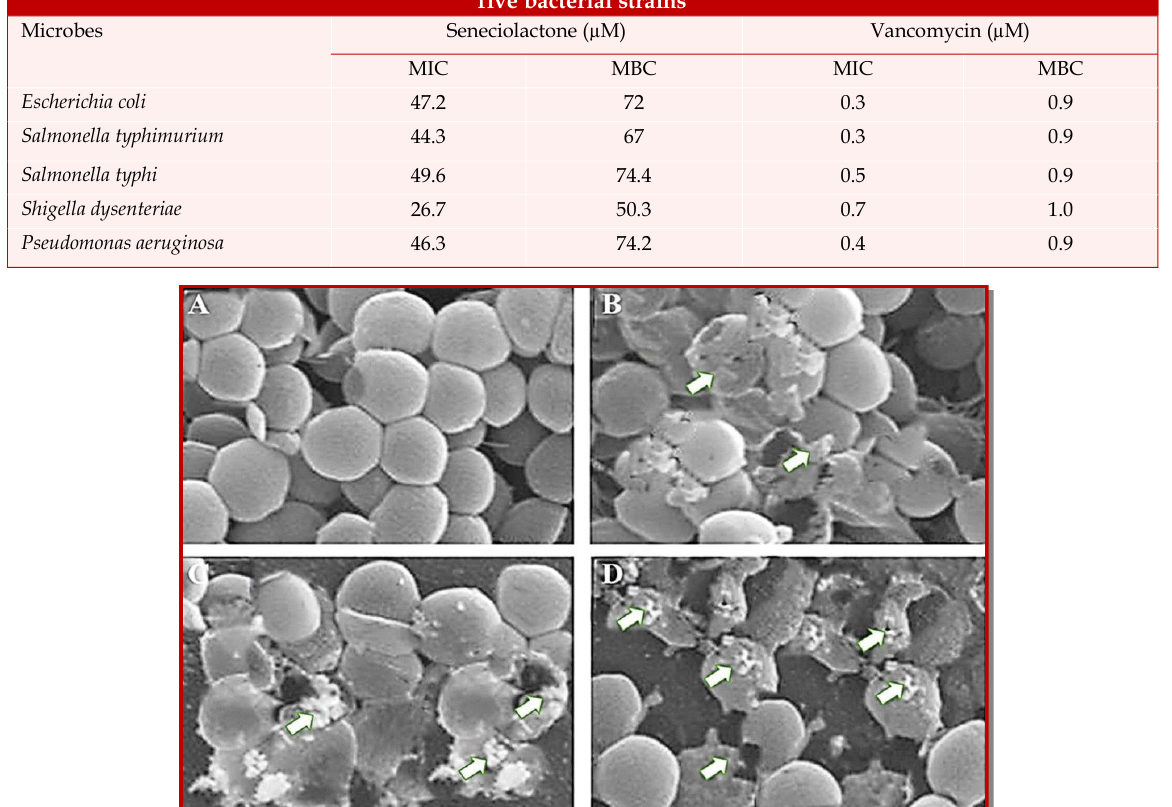
MIC and MBC values of seneciolactone and the standard antibacterial drug (vancomycin) against a panel of